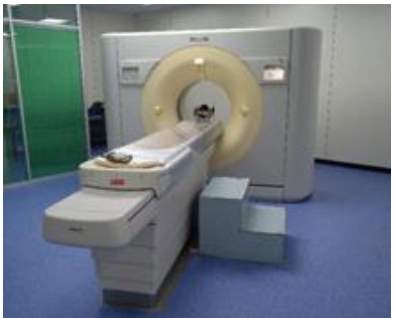
Figure 4. Testing equipment.